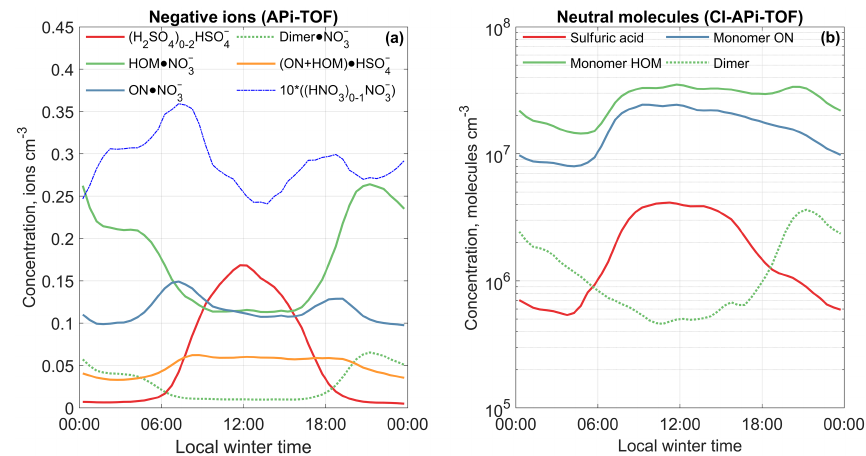
Figure 5. Averaged diurnal evolution of specific ion families (a) and neutral compounds (b) during days in clear sky conditions of measure- ments done in spring 2013. Colours and their corresponding families are denoted in the legends. Note that, in (a) , the signal of the nitric acid clusters (blue dotted line) have been multiplied by 10.